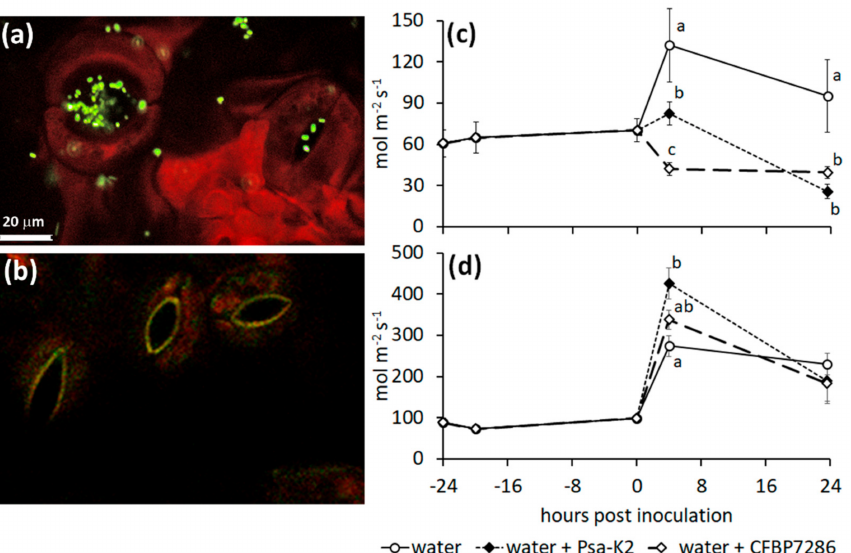
Figure 6. Stomata colonisation and stomata opening induced by Pseudomonas syringae pv. actinidiae . In vivo stomata colonisation ( a , b ) and stomatal conductance of Actinidia deliciosa ( c ) and A. chinensis ( d ) plants, after inoculation with Pseudomonas syringae pv. actinidiae strains CFBP7286 or Psa-K2. ( a ) In confocal laser scanning micrographs of Actinidia deliciosa stomata colonised by Pseudomonas syringae pv. actinidiae strains CFBP7286-GFPuv, each green rod is a single pathogen cell; ( b ) stomata in an uninfected leaf. ( c , d ) Stomatal conductance measured in real-time by gas exchange analyser (CIRAS-1). For each time point, significant differences (determined by ANOVA followed by Fisher’s least significant difference test with p ≤ 0.05, n = 4) are indicated by different letters.